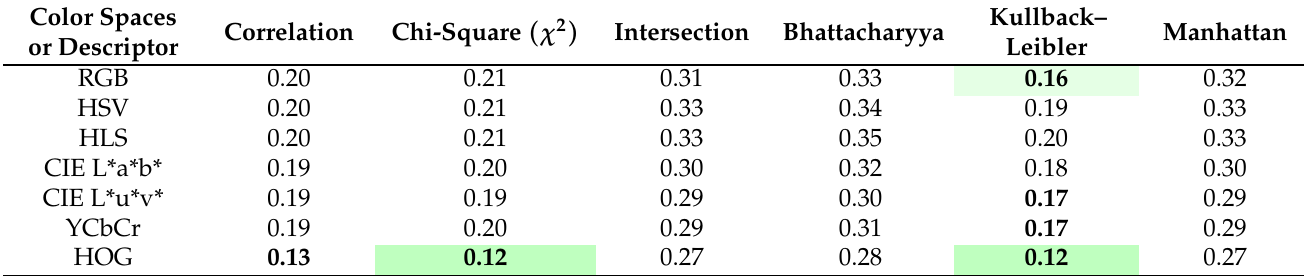
Table 7. S scores calculated for the 3rd video with 3